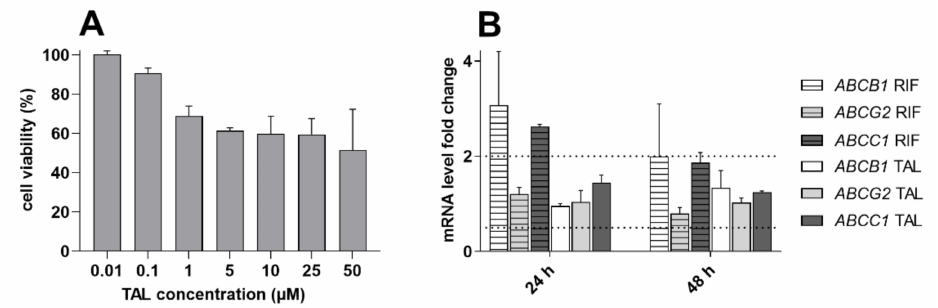
Figure 9. The effect of talazoparib treatment on the ABCB1 , ABCC1 , and ABCG2 mRNA levels in breast cancer MCF-7 model. ( A ) The MTT viability assay performed after the 48 h incubation with a tested drug. ( B ) Gene induction studies. The MCF-7 cells were treated with talazoparib (0.5 µ M) or rifampicin (25 µ M). The qRT-PCR technique was employed for the assessment of the target genes’ mRNA expressions after 24 and 48 h incubation interval. The dotted lines draw the boundaries for downregulation (lower line) and upregulation (upper line) according to the EMA’s DDI-testing guidelines [24]. The plotted data are means ± SD from three independent repetitions. RIF, rifampicin; TAL,